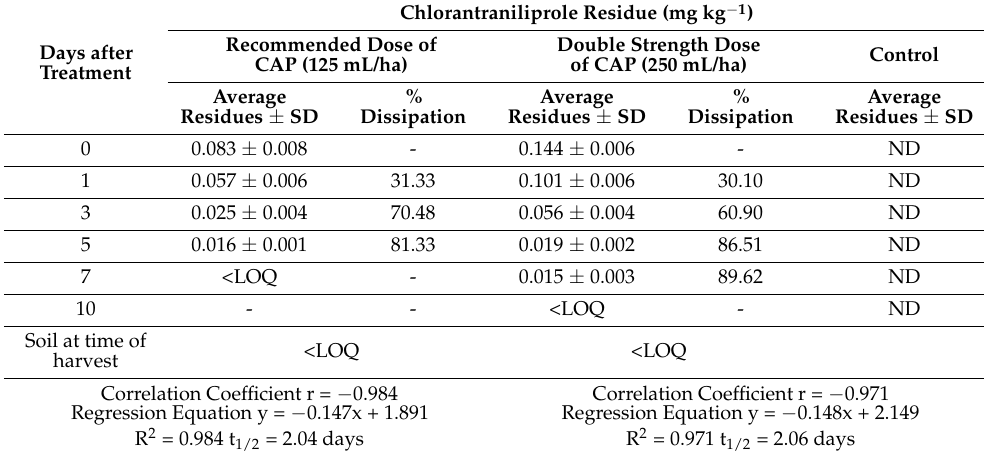
Table 4. Residues (mg kg − 1 ) * of chlorantraniliprole in okra fruits at single and double dose. Chlorantraniliprole Residue (mg kg − 1 ) Recommended Dose of Days after CAP (125 Treatment